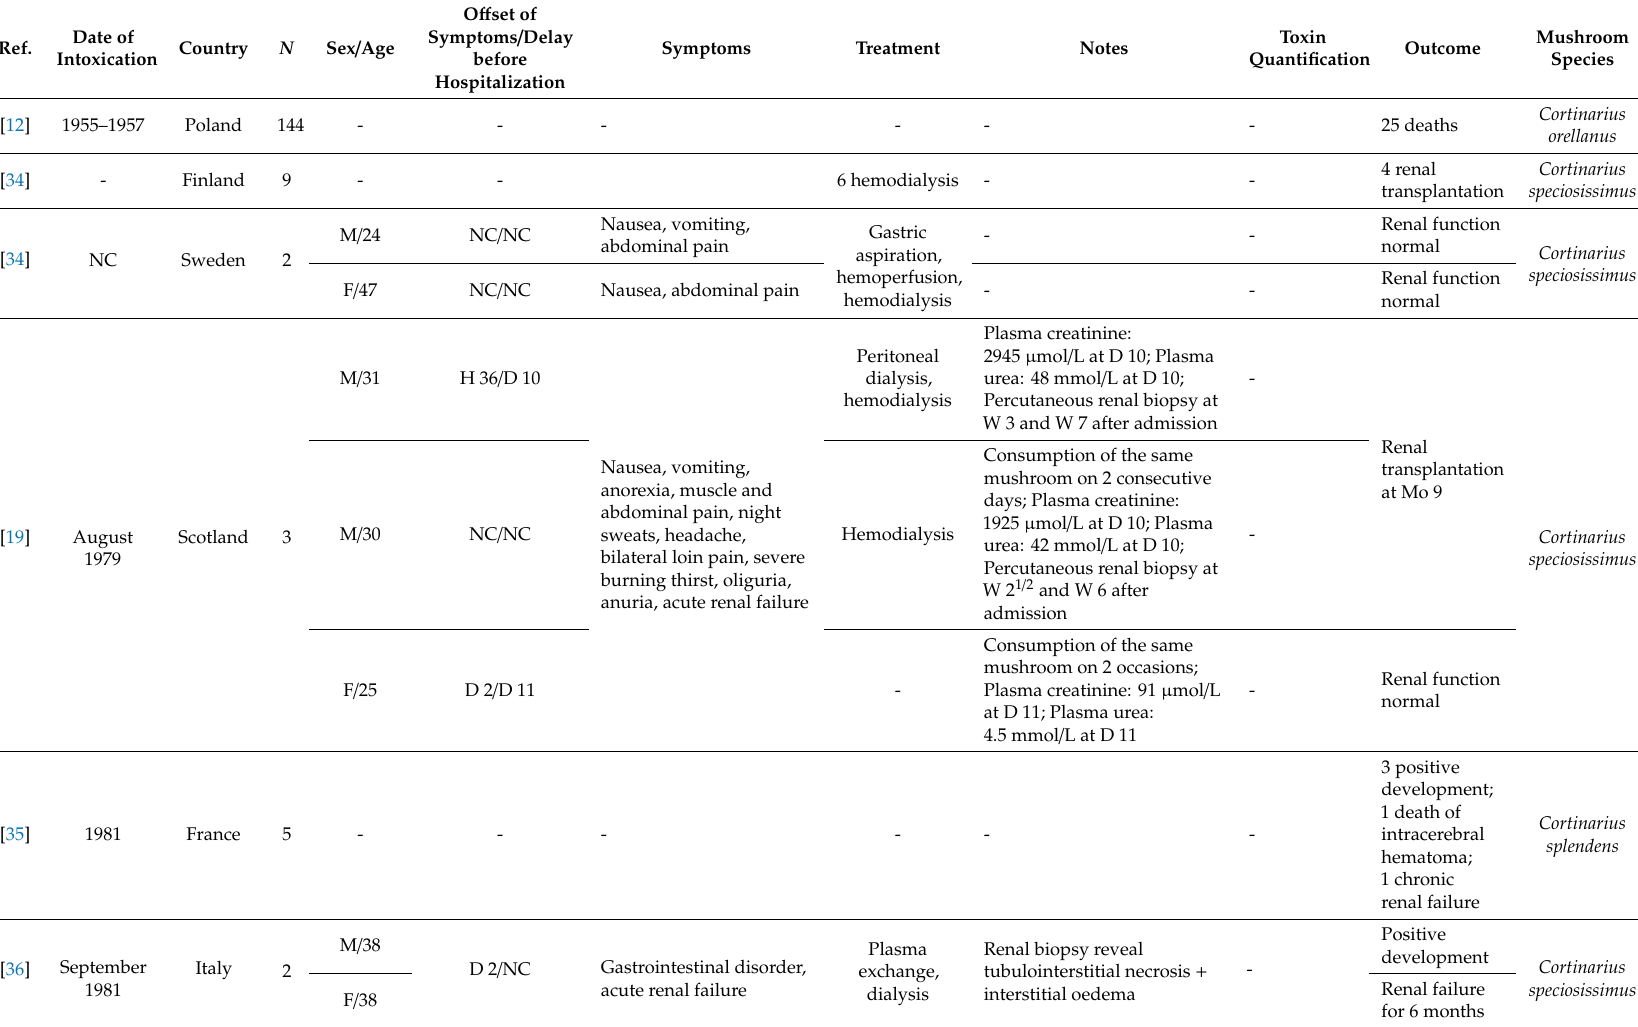
Table 1. Cases of orellanine